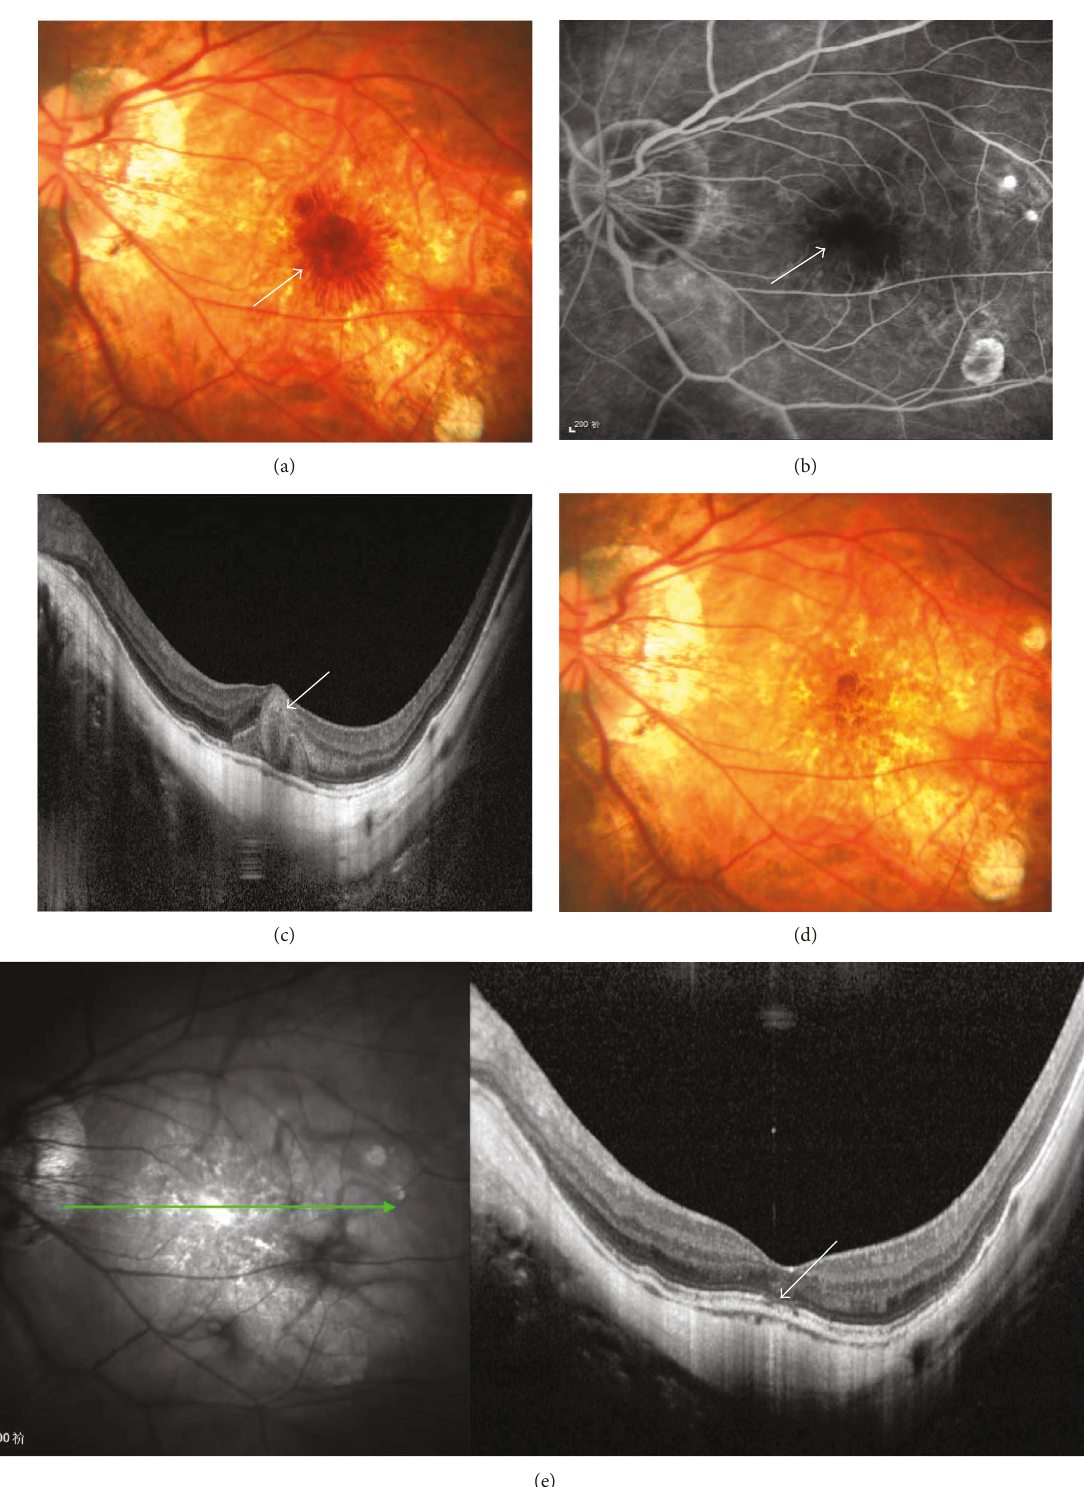
Figure 4: Multimodal imaging of an eye with a discontinuous ellipsoid zone. A 40-year-old woman was initially seen on December 3, 2013, with decreased visual acuity in her left eye. At the initial examination, the BCVA was 5/100, the refractive error was − 16.5D, and the axial length was 27.37mm in her left eye. An obvious subretinal hemorrhage (white arrow) was observed in the macular area at the initial examination (a). The late phase of FFA indicated that it was a simple hemorrhage (white arrow) (b). SD-OCT showed that the hemorrhage (white arrow) was thick and reached beyond the ellipsoid zone (c). After 3 years of follow-up, no recurrent hemorrhage or CNV occurred. Because the ellipsoid zone (white arrow) at the central fovea was not continuous (e), the fi nal BCVA of the eye was poor